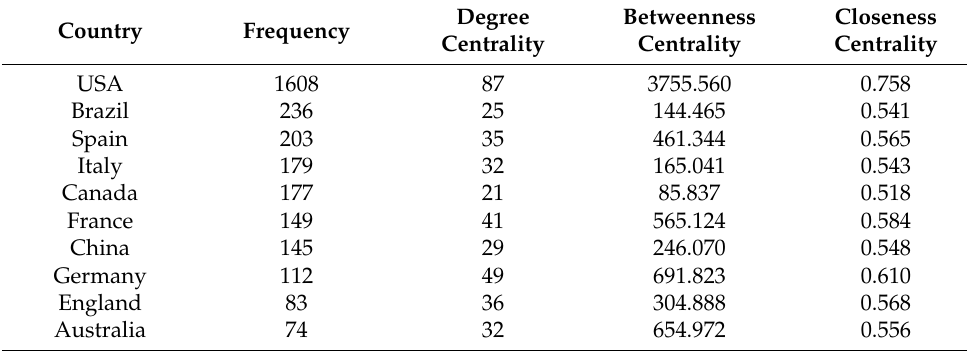
Table 9. Top 10 countries based on the